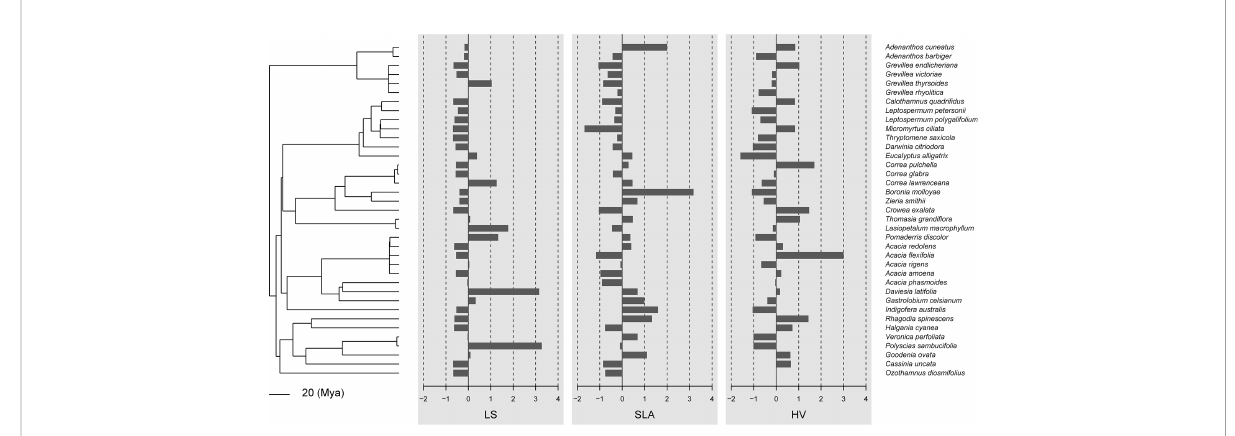
FIGURE 1 Data visualization of the three morphological traits (leaf size, speci fi c leaf area, and Huber values) mapped along the phylogeny of 37 shrub species. If these traits were phylogenetically conserved, closely related species should share similar bar lengths. By default, data are centered and scaled by